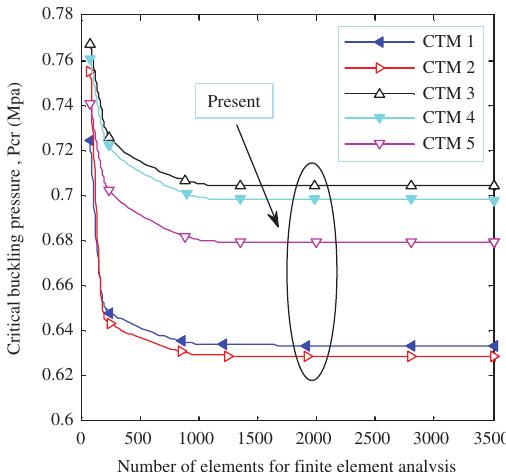
Figure 2: Sensitivity analysis.